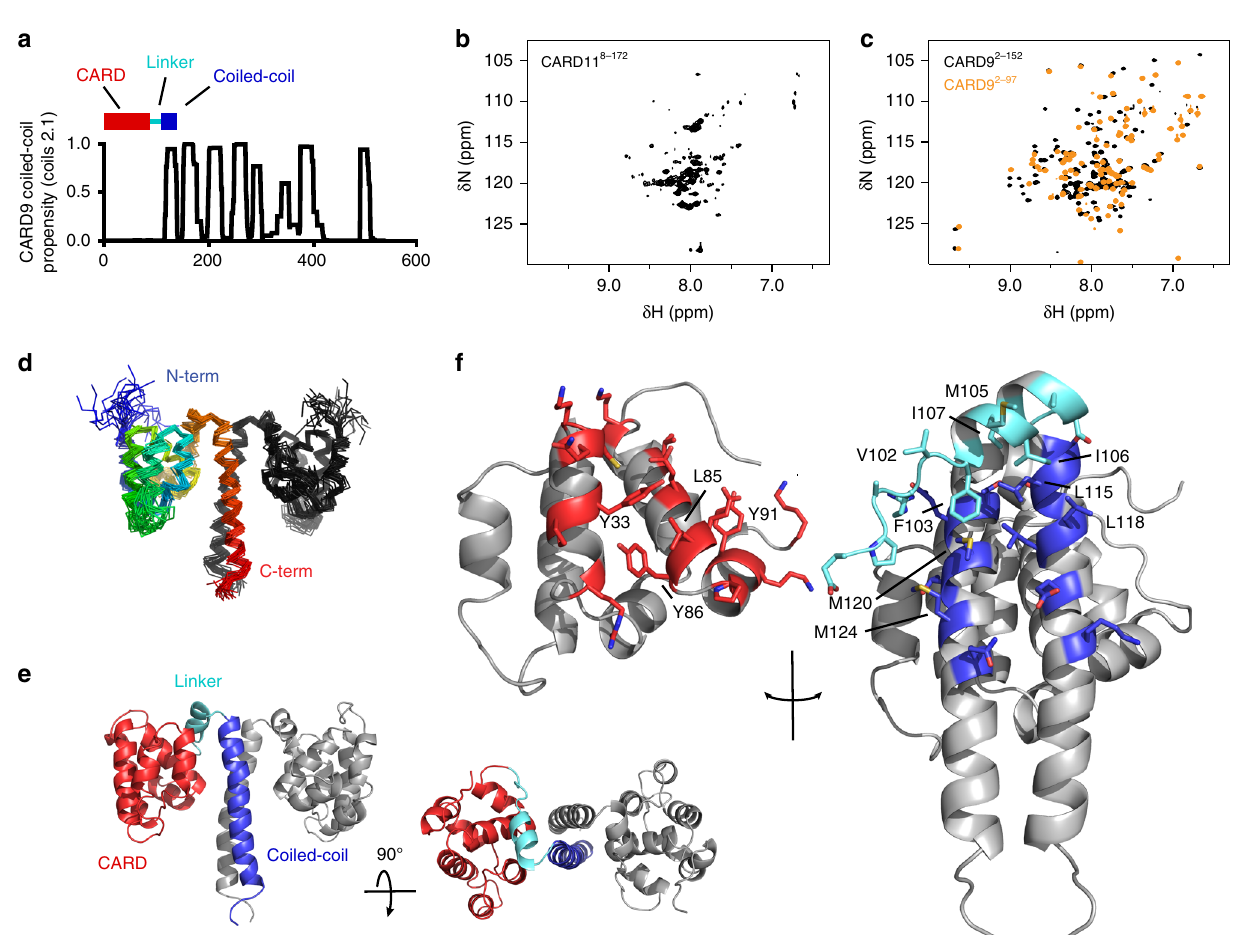
Fig. 1 CARD9 2 − 142 forms a dimer with an extensive CARD-linker-coiled-coil interface. a Coiled-coil propensity for full-length CARD9, as predicted by the COILS server 73 . Schematic of the construct composition is shown above. b 15 N-TROSY of CARD11 8 – 172 , collected at 37 °C. c 15 N-TROSY of the CARD9 2 – 152 dimer (black) and 15 N-HSQC of CARD9 2 − 97 (orange) at 37 °C. The CARD9 2 − 97 spectrum was shifted to account for the difference in chemical shifts recorded by TROSY and HSQC experiments. d Ribbon diagram of the 20 lowest energy CARD 2 − 142 dimer structures calculated. One of the two monomers is colored as a rainbow from N- to C-terminus. e Lowest energy CARD9 2 − 142 structure, with sub-domains of one monomer colored as in Fig. 1a. f “ Open- face ” depiction of the CARD-coiled-coil interface. Residues of the CARD, linker, and coiled-coil for which heavy atoms are within 2.5 Å of another sub- domain in any of the lowest energy structures are shown as sticks and colored in red, cyan, and blue, respectively. Residues forming the hydrophobic core of the interface are